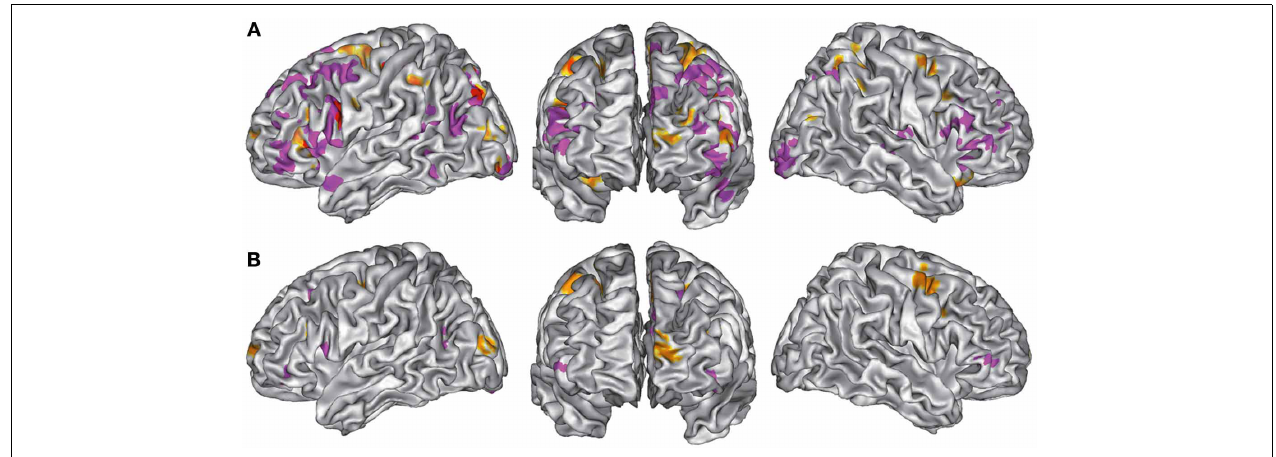
FIGURE 3 | (A) ALE maps of verbal task foci (in purple) and non-verbal task foci (in orange). Overlaps between maps are shown in red. All maps were thresholded at a whole-brain cluster-level corrected p < 0 . 05. (B) ALE maps resulting from contrast studies of verbal vs. non-verbal task foci (in purple)